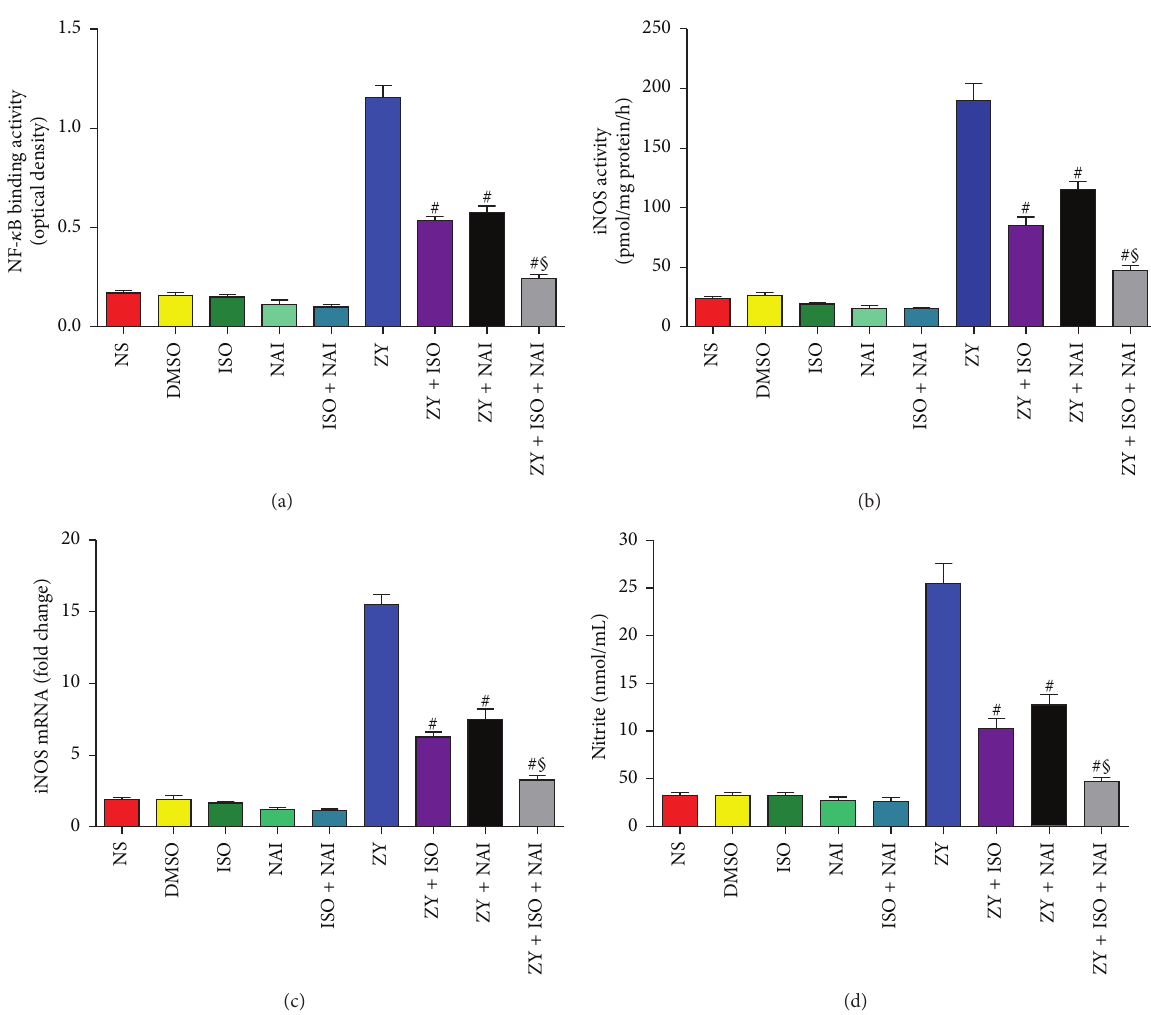
Figure 8: ISO at 0.7% inhibited ZY-induced NF- 𝜅 B activation, iNOS activity, and NO production in neutrophils. (a) NF- 𝜅 B DNA-binding activity.(b)iNOSmRNAexpressionasassessedbyqPCR.(c)iNOSenzymeactivity.(d)AssayofnitritelevelsasanindicatorofNOgeneration. The neutrophils were treated as shown in Figure 1(b). Data represent means ± SD for triplicates of each group. # 𝑃 < 0.05 versus ZY + vehicle (ZY). § 𝑃 < 0.05 versus ZY + ISO. NAI, NF- 𝜅 B activation inhibitor. DMSO is provided as a solvent control for